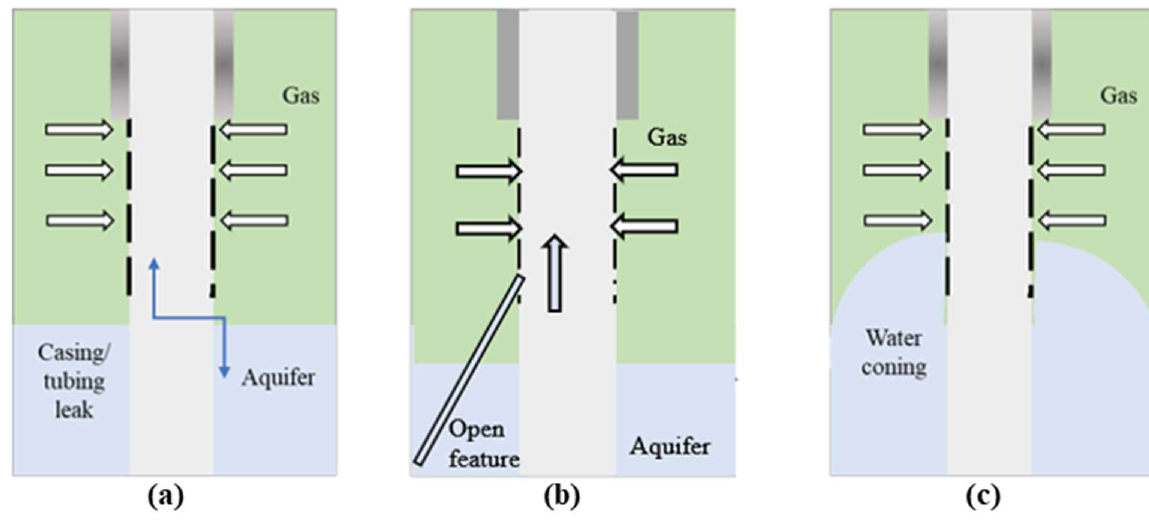
Figure 1. Sources of excess water in gas production wells, ( a ) Casing/tubing leak, ( b ) Open fracture, ( c ) Water coning.